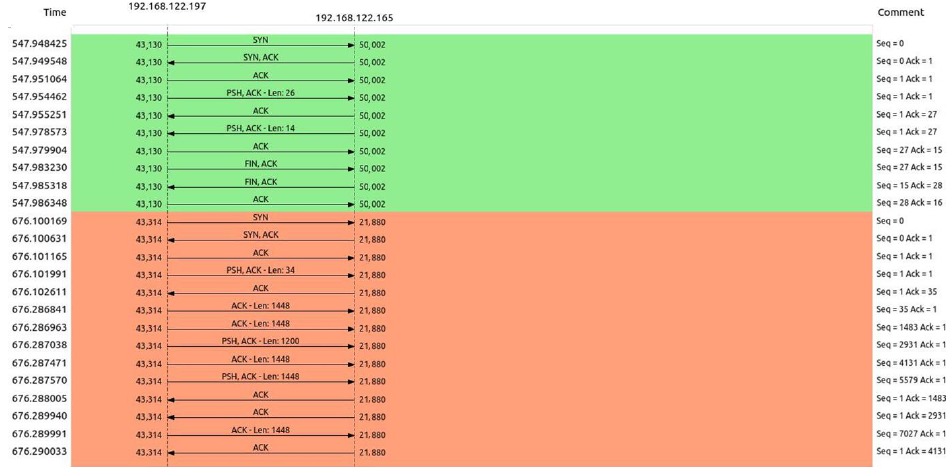
Figure 5. TCP stream graph.